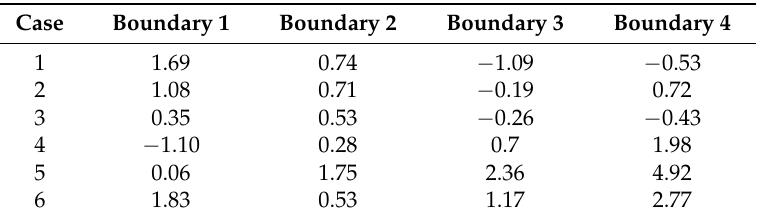
Table 7. Simulation errors of the steady conductor temperatures by FEM simulation using the calculated thermal resistances (°C).